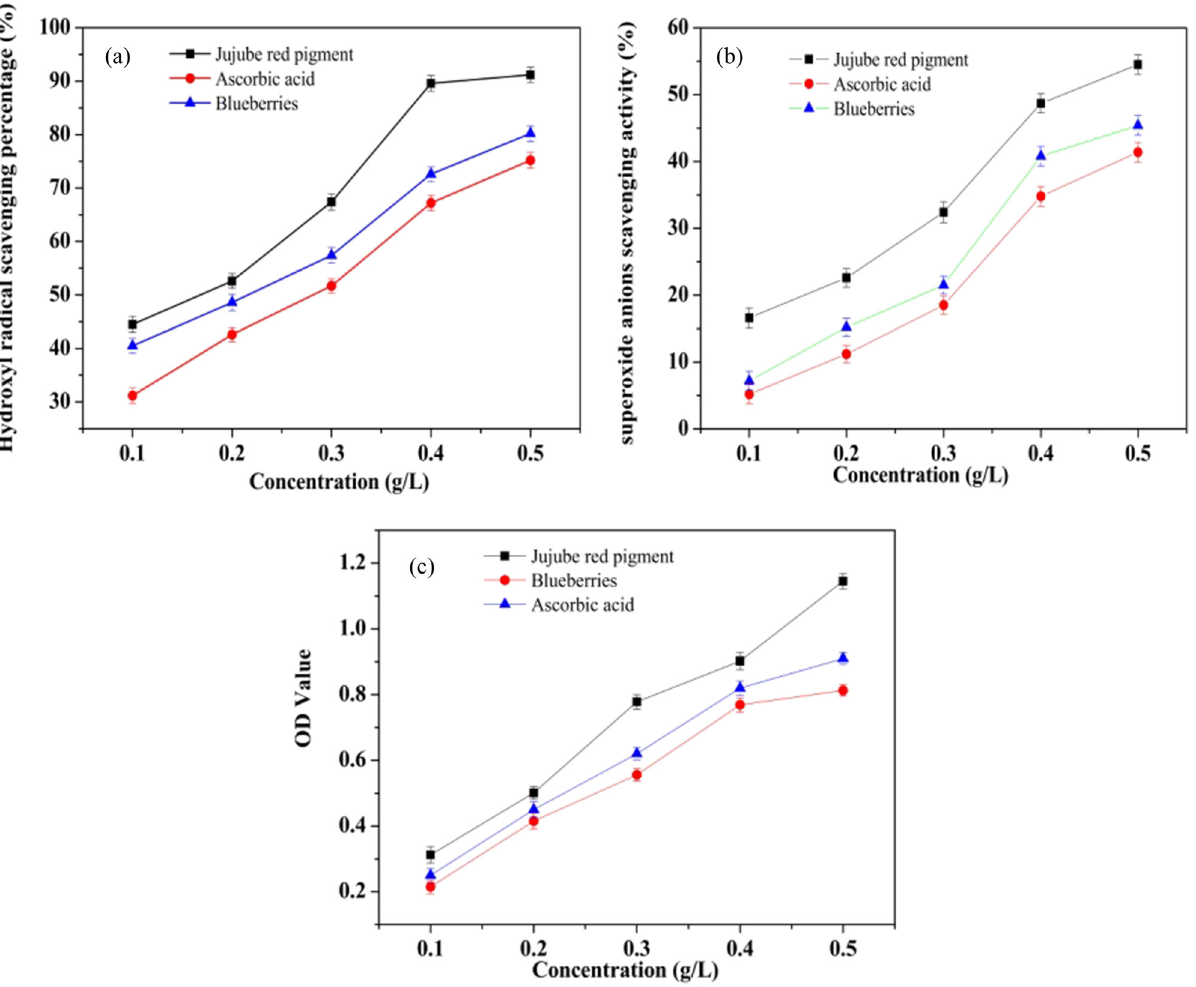
Figure 5: Antioxidant activity of pigment extracts. E ff ects of pigment extracts on hydroxyl radical scavenging capacity ( a ) , superoxide scavenging capacity ( b ) , and Fe 3 + reducing power ( c ) during in vitro experiment. Means associated with the same letter are not signi fi cantly di ff erent ( n = 3; error bar, a standard deviation of the sample, SD )